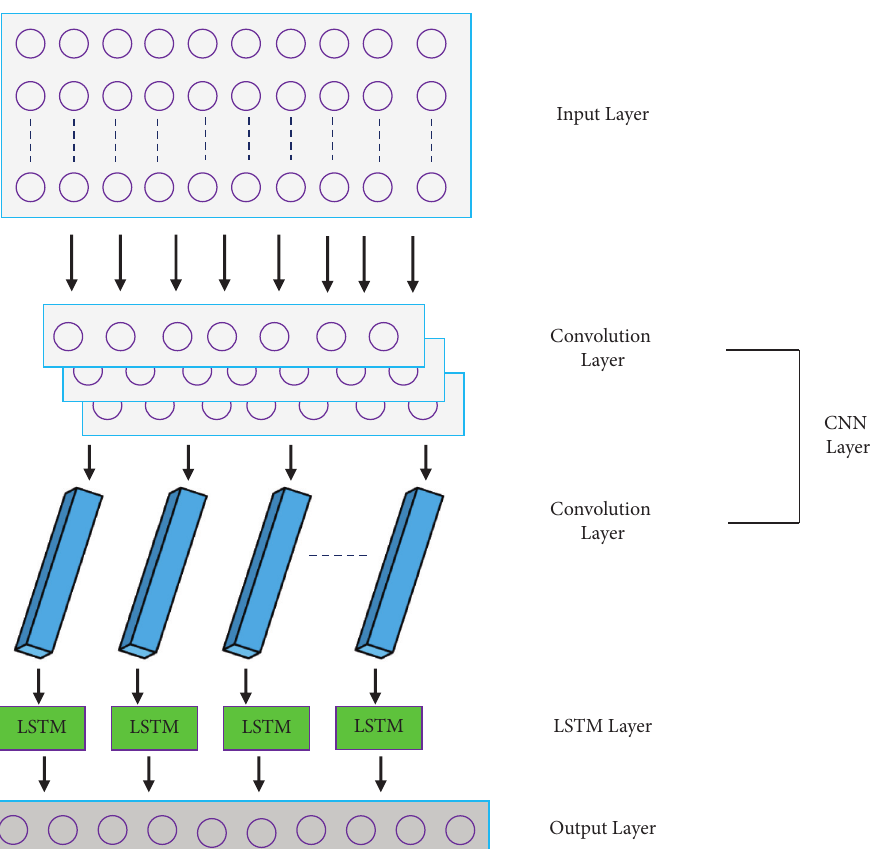
Figure 3: Architecture of